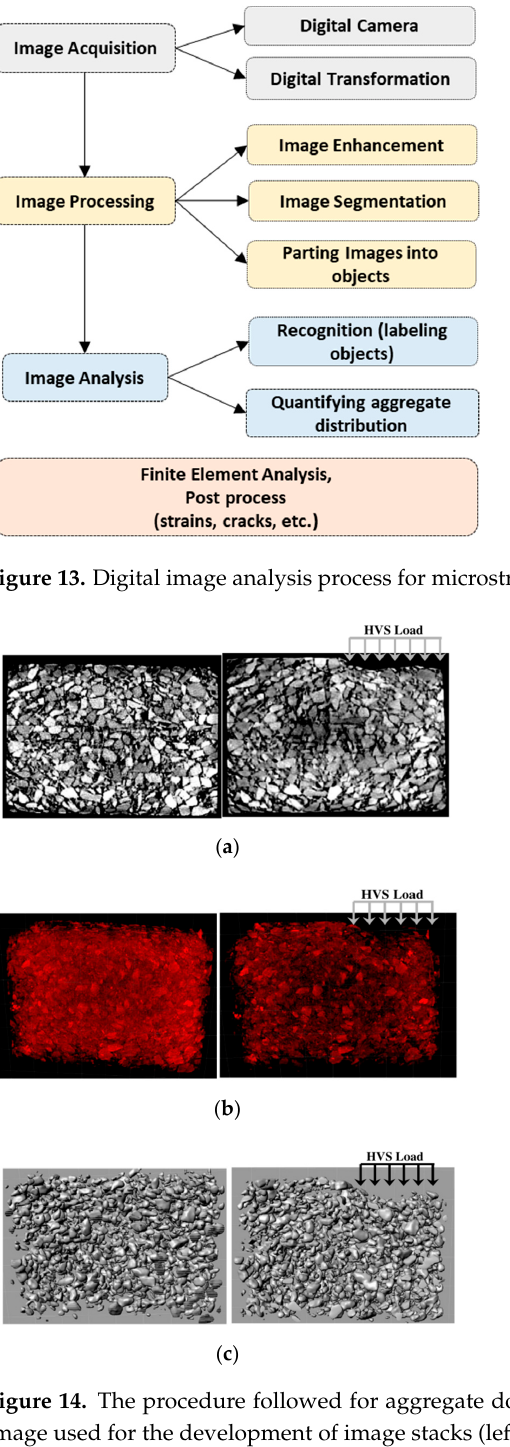
Figure 12. Effect of anisotropy on the stress–strain relationship predicted by the model. Reprinted